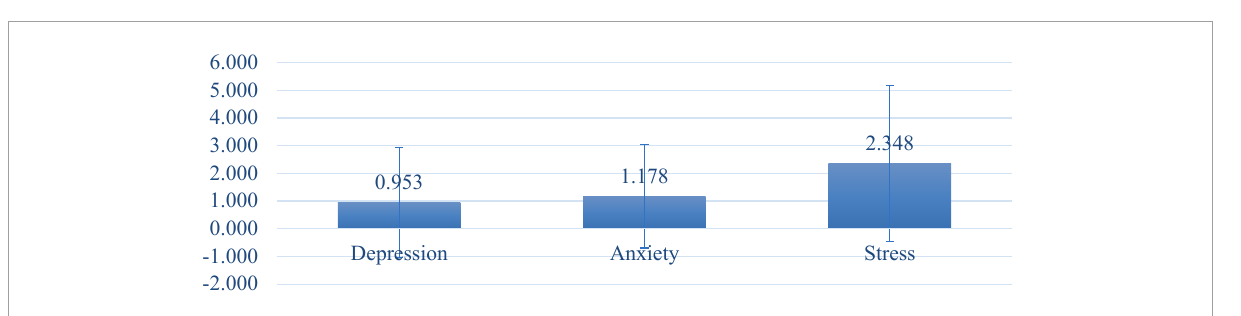
FIGURE2 Mean score of depression, anxiety, and